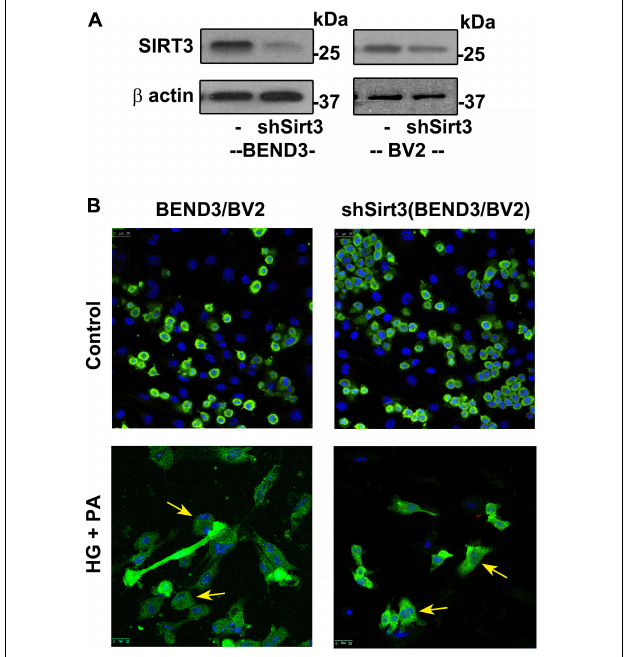
FIGURE 5 | Effects of SIRT3 deficiency on microglial and endothelial cell interactions. (A) Lysates, from BEND3, shSirt3-BEND3, BV2, and shSirt3-BV2 cells, were immunoblotted for SIRT3 and β -actin. (B) Mixed cultures of BEND3/BV2 and shSirt3-BEND3/shSirt3-BV2 were incubated in the absence and presence of high glucose (HG 30 mM) and palmitic acid (PA 300 µ m) for 48 h. The treated cells were fixed and immunostained for Iba1 with Alexa Flour 488 (green). Nuclei were stained blue with DAPI. Images of stained cells were captured with the Leica SP8 confocal microscope with white laser, using a Leica HC PL APO 40 × 1.30 NA oil objective. shSirt3, Sirt3-silenced. FIGURE 6 | Measurement of barrier function in endothelial cells (TEER). (A) An